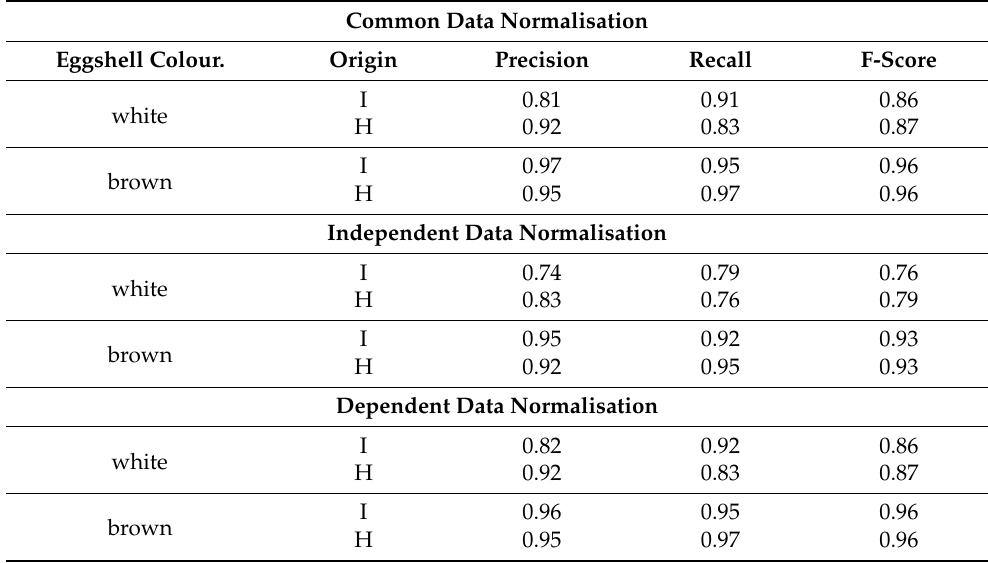
Table 2. Quality of the origin classifications of white and brown eggs obtained using the described portable multispectral fibre-optic reflectometer and the SVM algorithm. I.—eggshells obtained from infected hens, H.—eggshells obtained from healthy